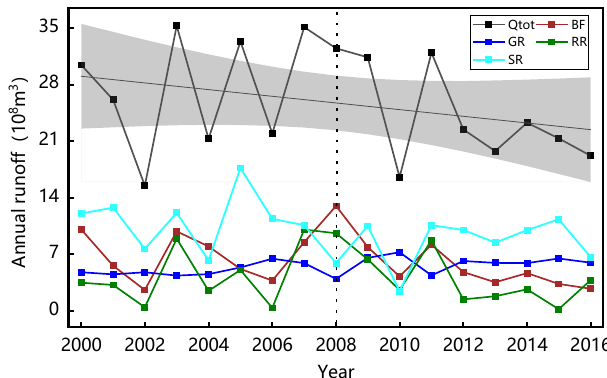
Figure 9. Interannual variation of lake inflow and its runoff components during the simulated period.